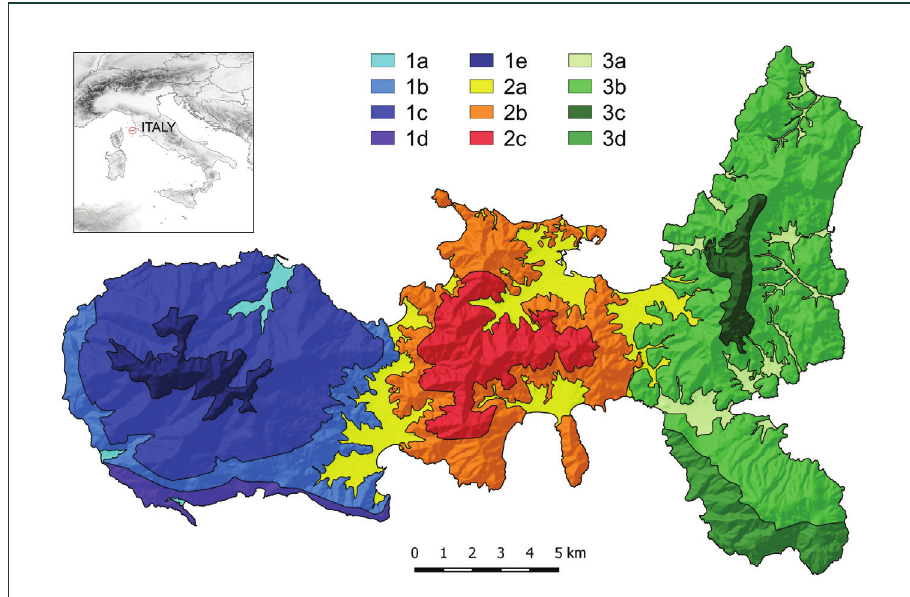
Figure 1. Localisaton of Elba island (red circle) in the Central Mediterranean area and subdivision of the island into 12 Operational Geographic Units. The numbers distinguish the western ( 1 ), central ( 2 ), and eastern ( 3 ) portion of the island, while the letters distinguish ecological belts as follows: ( a ) alluvial plains, stream banks and shores, ( b ) hilly areas below 250 m a.s.l., mostly characterised by a mesomediterranean thermotype and a subhumid ombrotype, ( c ) hilly and mountain areas generally above 250 and below 700 m a.s.l. characterised by mesomediterranean thermotype and humid ombrotype, ( d ) coastal hilly areas with a thermomediterranean thermotype, and ( e ) mountain areas above 700 m a.s.l. characterised by mesomediterranean and supramediterranean